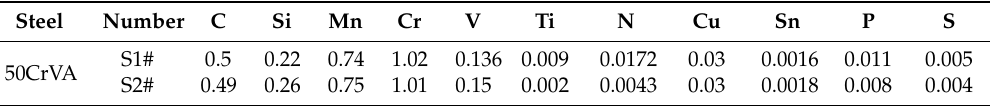
Table 1. Chemical compositions of the tested 50CrVA spring steel